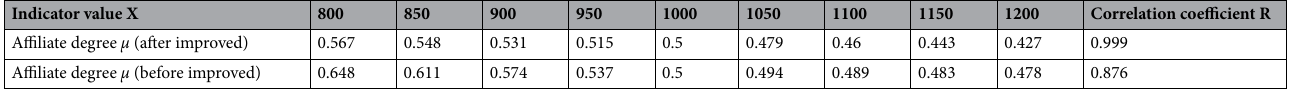
Table 2. Comparison of correlation coefficients of indication example and membership degree before and after